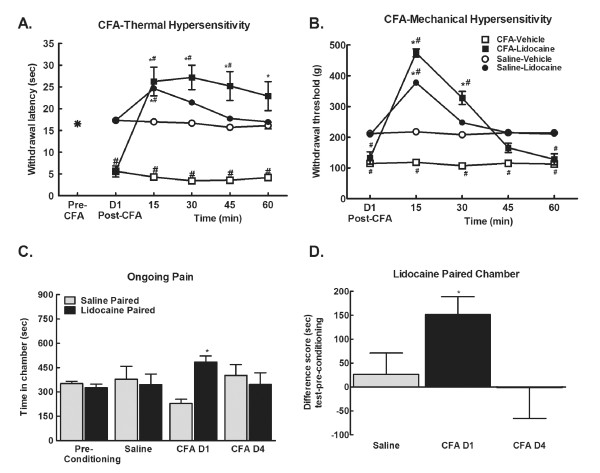
A. CFA reduced withdrawal latency within 24 hrs post-CFA. Popliteal fossa lidocaine (4% w/v, 200 μl) reversed CFA-induced hypersensitivity, elevating paw withdrawal latencies to noxious thermal stimulation to almost cut-off in both CFA and control (saline) treated rats at the 15 min time-point. Elevated paw-flick latencies were observed throughout the 60 min testing period in the CFA treated rats, and returned to pre-lidocaine latencies within 45 min in the control rats, *p < 0.05 vs. post-CFA, #p < 0.05 vs. pre-CFA, n = 5-6. B. CFA decreased withdrawal thresholds to noxious mechanical stimulation within 24 hrs. Popliteal fossa lidocaine elevated paw-withdrawal thresholds to almost cut-off in both the CFA and saline (control) groups at the 15 min time-point. Paw-withdrawal thresholds returned to pre-lidocaine values within 30 min for control rats, and within 45 min in the CFA treated rats, *p < 0.05 vs. post-CFA, #p < 0.05 vs. pre-CFA, n = 5-6. C. Popliteal fossa lidocaine induced CPP 24 hrs, but not 4-days post-CFA injection. *p < 0.05 vs. pre-conditioning, p < 0.05, n = 5-6. D. Difference scores calculated as test time - preconditioning time spent in lidocaine chamber confirm that only rats treated with CFA 24 hours prior to conditioning showed CPP in response to peripheral nerve block by lidocaine. *p < 0.05 vs. saline treated group.